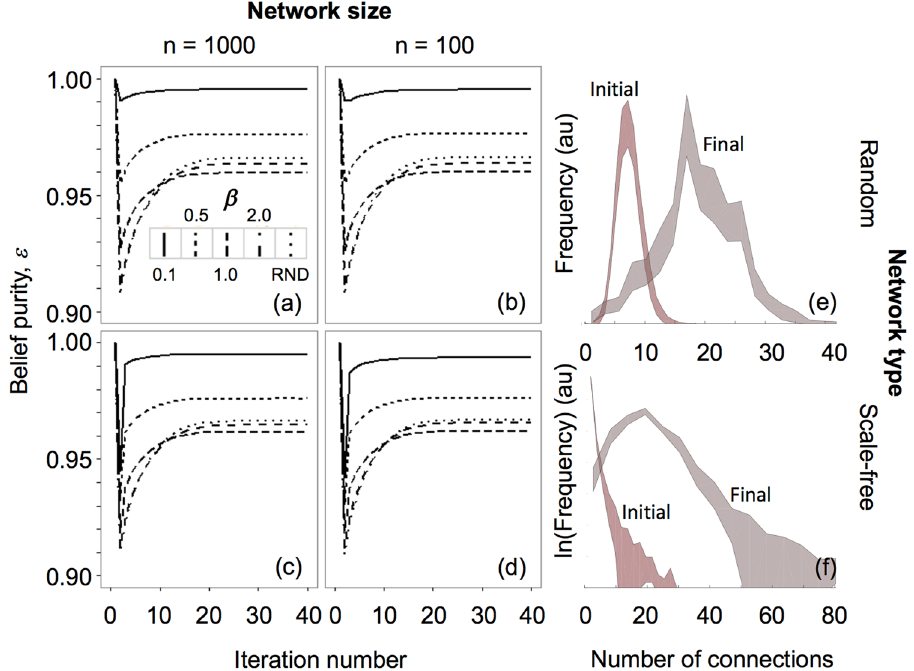
Figure 3. Figures a–d show the degree of epistemic similarity between nodes in a network. Top row is stochastic placement, bottom row is Scale-Free placement ( γ = 2.5). Columns depict reach in stochastic placement ( α = 0.1, and ανδ 1) and number of agents in Scale-Free placement (n = 100, 1000). β -values range from strongly confirmatory to unused ( β = 0.1, 0.5, 1.0, 2.0, and unused). Figures e,f show agent connection frequency distributions for 5 th (‘Initial’) and 50 th (‘Final’) iterations, for random and scale-free placement (95% confidence intervals over 100 repeat simulation